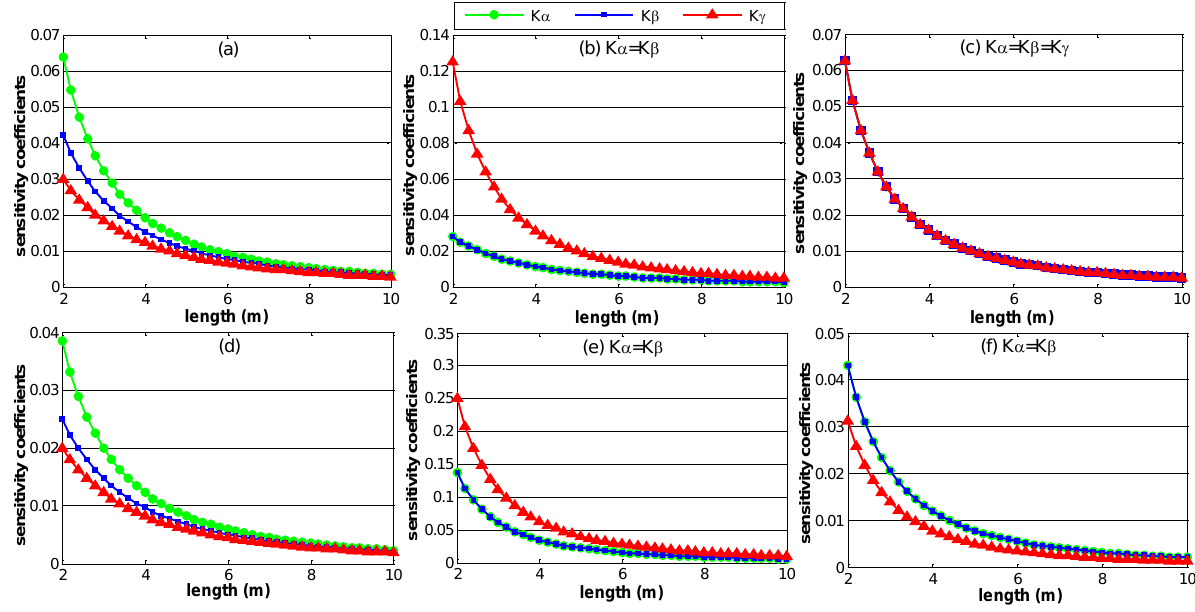
Figure 5. The sensitivity coefficients of rotation parameter errors versus volume size. ( a ) Sensitivity coefficients of layout a; ( b ) Sensitivity coefficients of layout b; ( c ) Sensitivity coefficients of layout c; ( d ) Sensitivity coefficients of layout d; ( e ) Sensitivity coefficients of layout e; ( f ) Sensitivity coefficients of layout